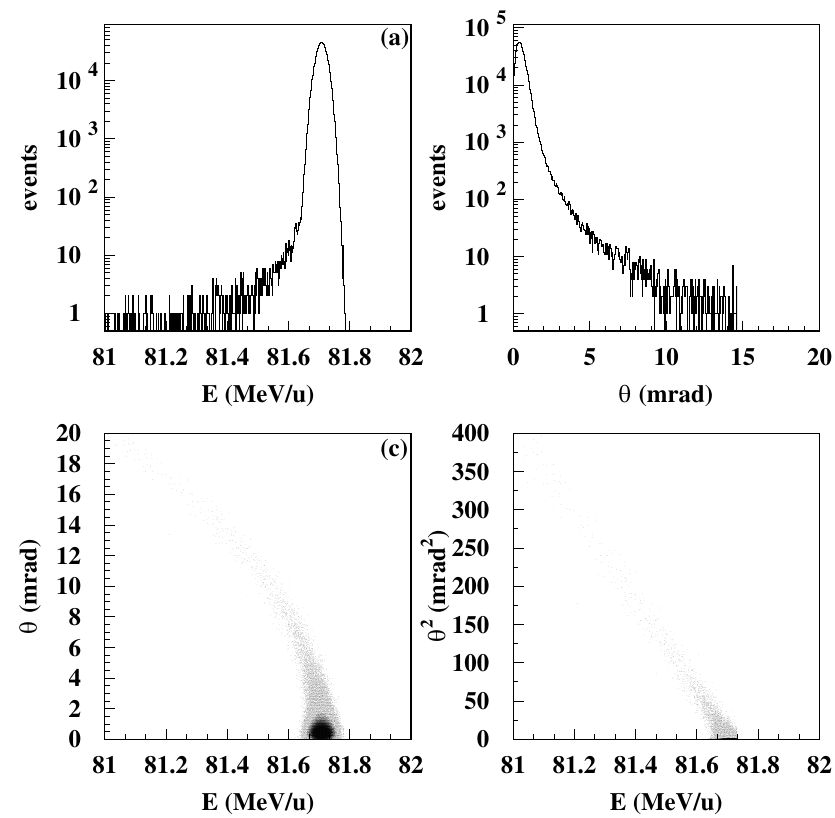
FIG. 1. Results of SRIM calculations for 10 6 238 U ions at 85 MeV =u incident on 15 mg = cm 2 carbon stripper foil. (a) Energy distribution, (b) distribution of scattering angles, (c) strong energy-angle correlation which becomes linear on the energy-angle squared plane